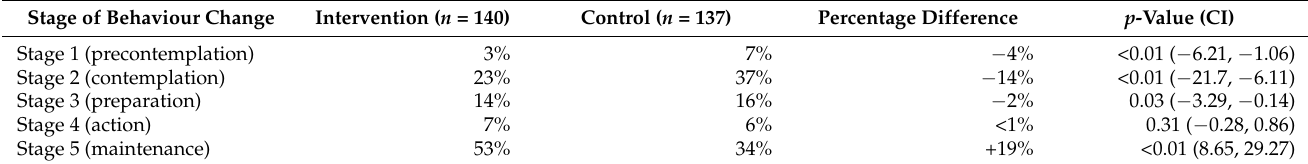
Table 3. Percentage predicted probabilities of postintervention behaviour-change scores based on study group allocation (intervention vs.